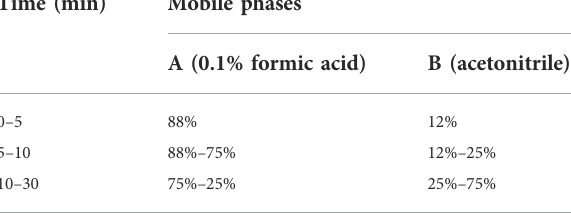
TABLE 2 Gradient elution program for fl avonoids (detection wavelength: 360 nm). Time